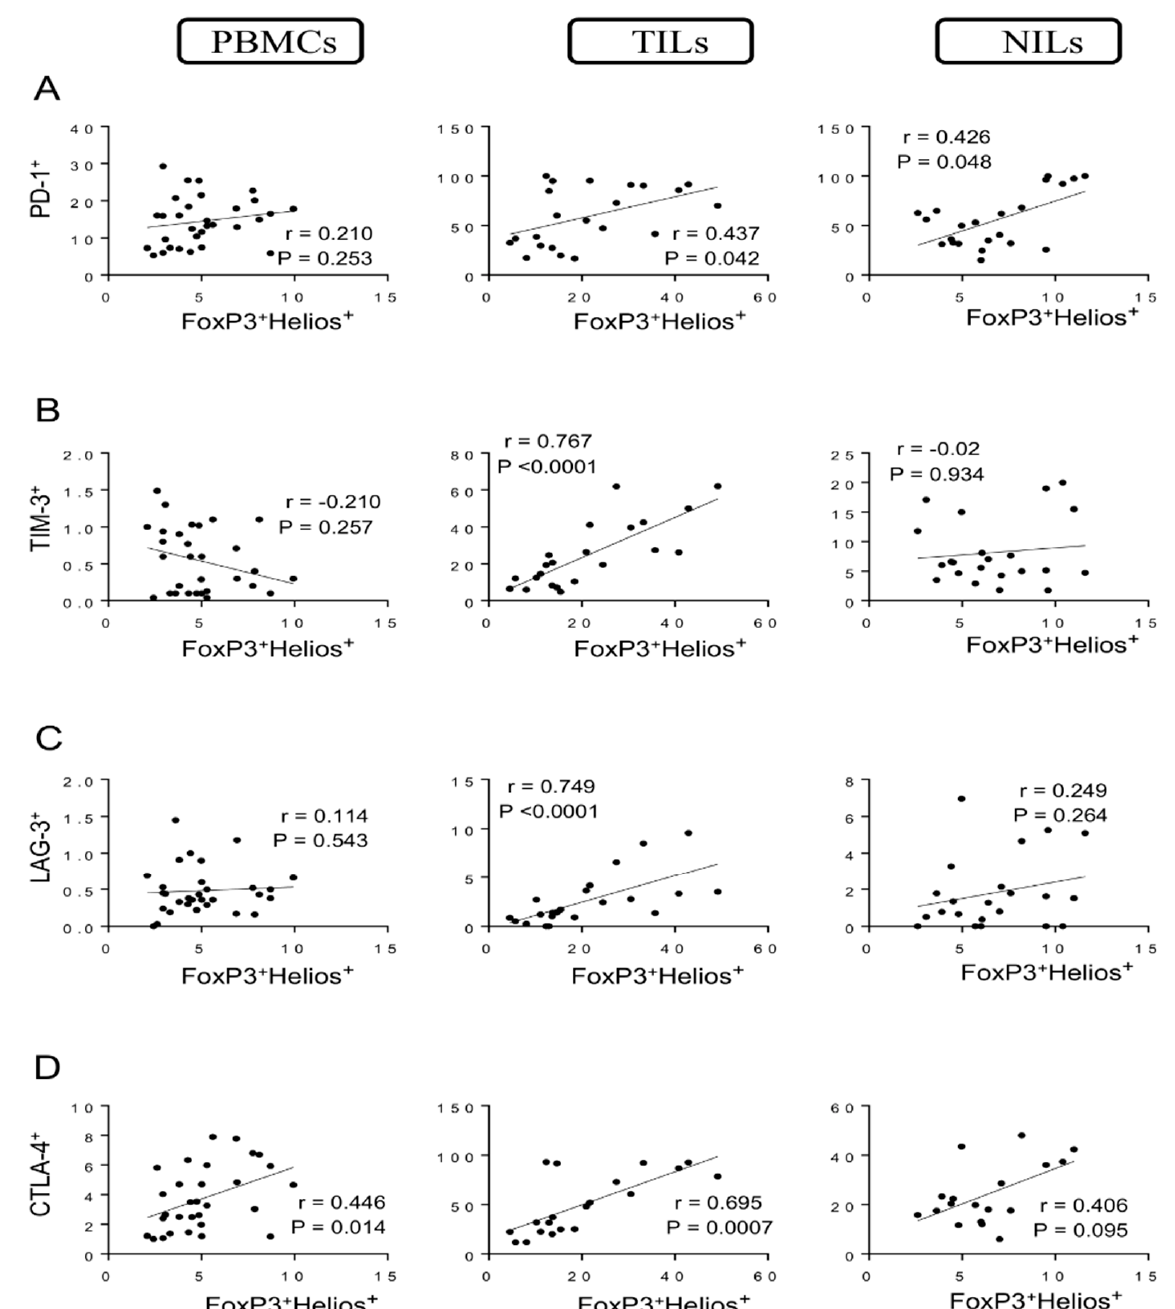
Figure 3. Correlations between levels of FoxP3 + Helios + and immune checkpoints in CD4 + T cells in CRC patients. Correlations between levels of CD4 + FoxP3 + Helios + Tregs with PD-1 + ( A ), TIM-3 + ( B ), LAG-3 + ( C ), and CTLA-4 + ( D ) in PBMCs, TILs, and NILs.